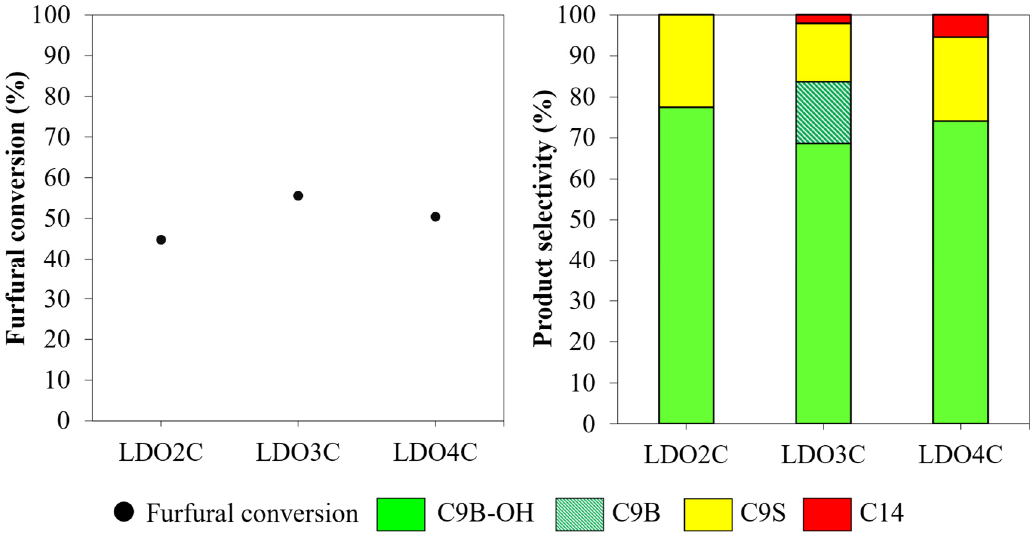
Figure 4. Furfural conversion and product selectivity obtained from aldol condensation of furfural and 2-butanone over LDO catalysts with different Mg/Al atomic ratios. (Reaction conditions: furfural:2-butanone, 1:2; catalyst loading, 5 wt.%; time, 8 h; temperature, 80 °C; N 2 pressure, 10 bar).